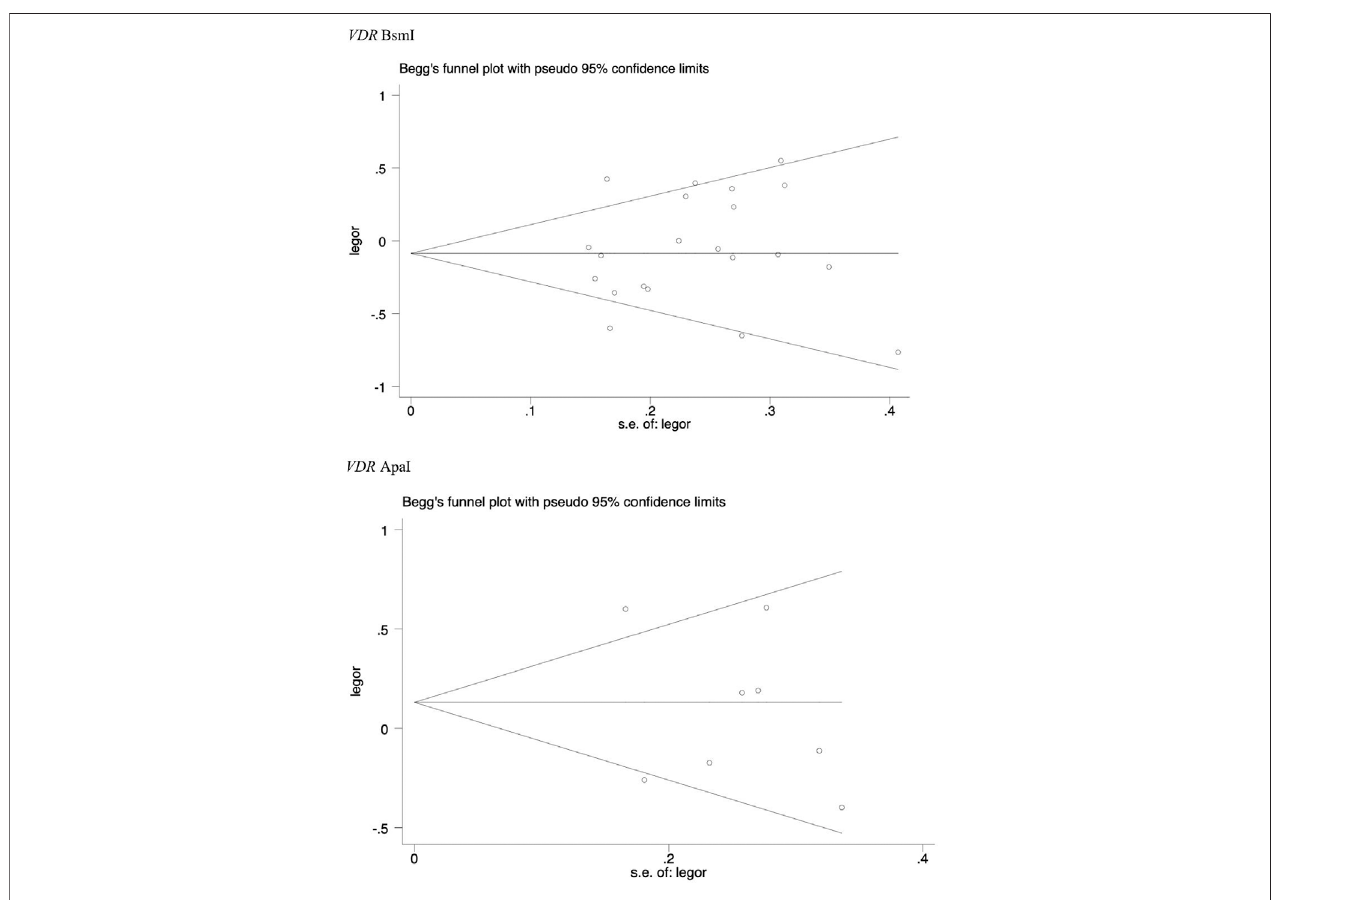
FIGURE 7 | Begg ’ s funnel plot to access publication